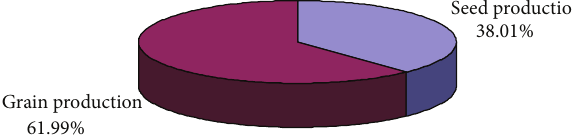
Figure 1: Area under seed and grain production among pigeonpea seed